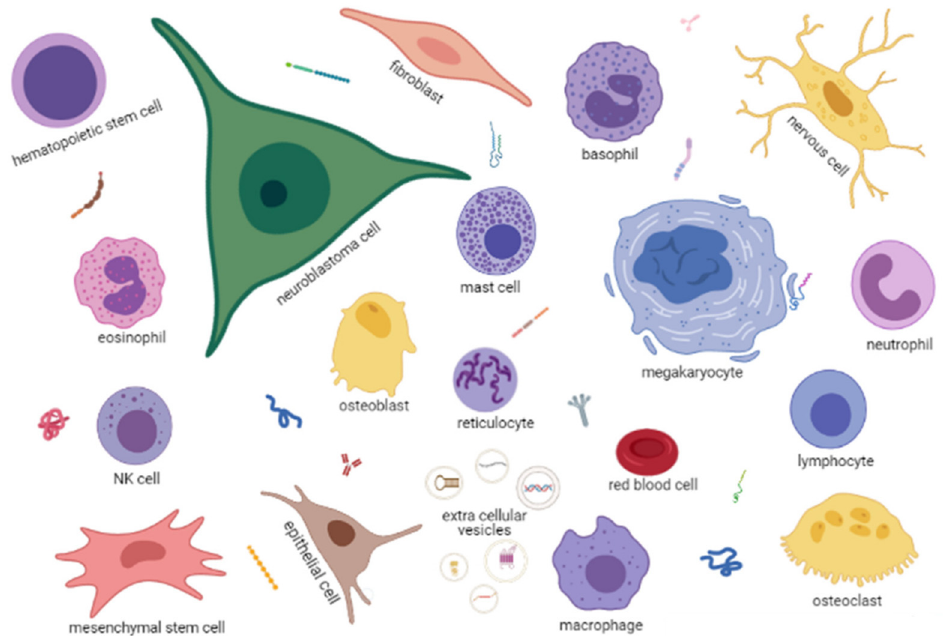
Figure 2. A cartoon, created in Biorender.com, depicting the BM microenvironment in NB. Each cell type is named in the figure. Extracellular vesicles of different dimensions with different types of cargo (DNA, miRNA, mRNA, proteins) are indicated in the bottom center of the figure. Different types of soluble proteins, such as antibodies, cytokines, enzymes etc., are scattered among the cells. Created with BioRender.com (accessed on 18 May 2021).